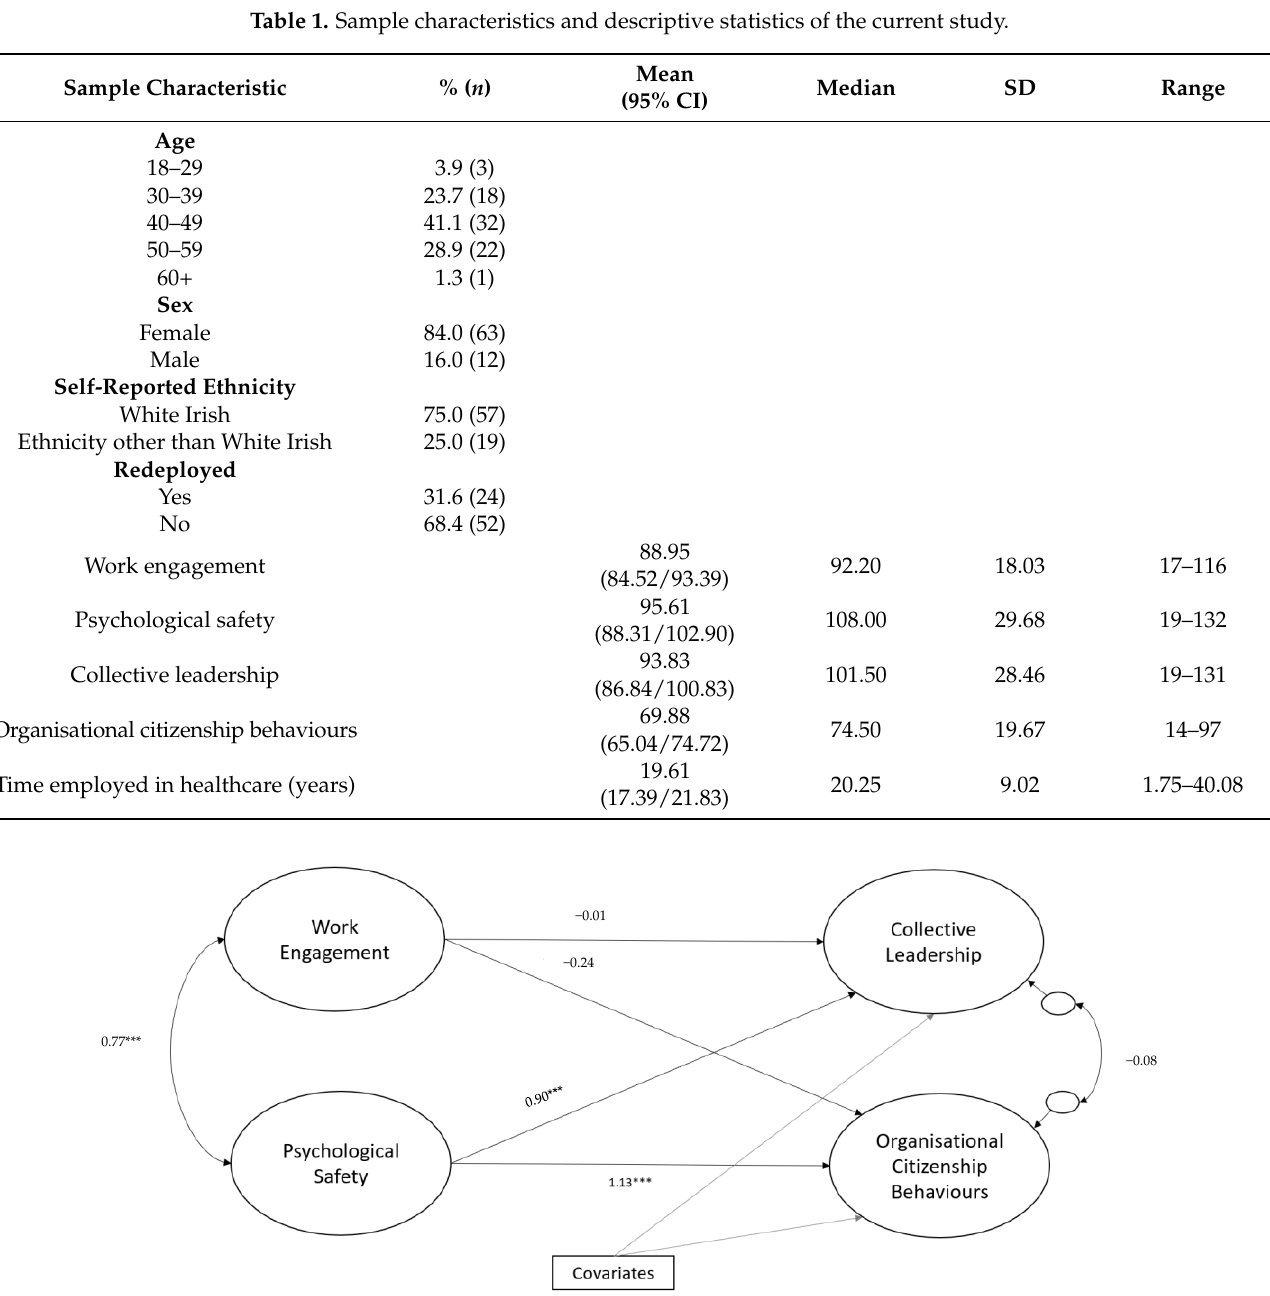
Figure 1. Structural model illustrating the relationship (standardised estimates) between work engagement and psycho- logical safety, and collective leadership and organisational citizenship behaviours. Note: Individual exogenous covariate pathways are omitted for visual clarity. Statistical significance: *** p < 0.001.